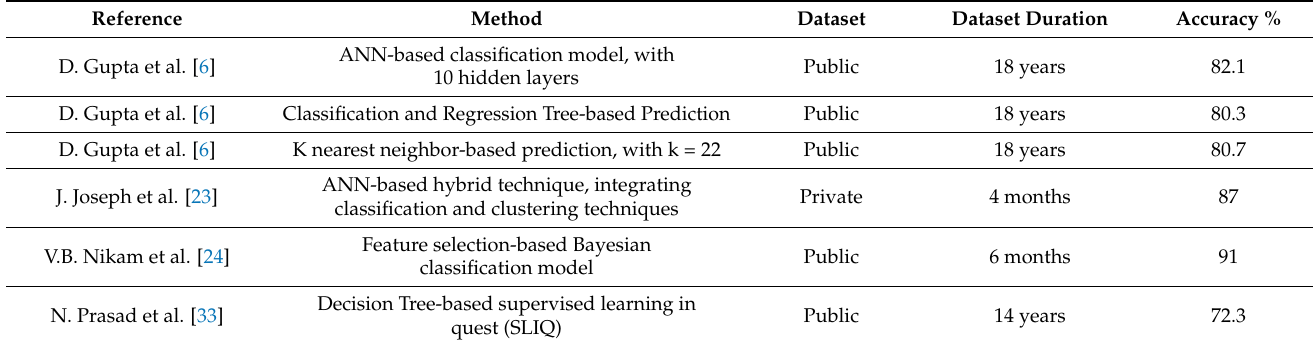
Table 1. Summary of previous related